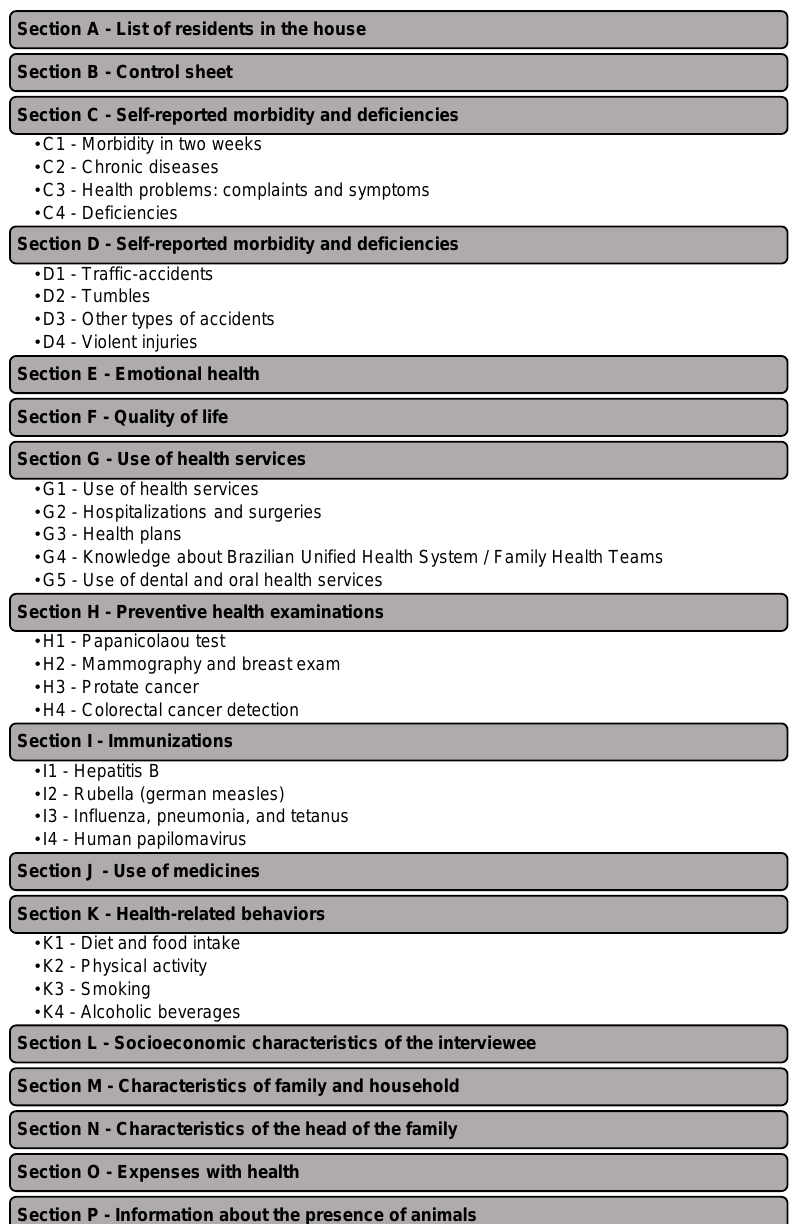
Figure 2. Sections of the questionnaire used in the 2015 ISA-Capital. S ã o Paulo,